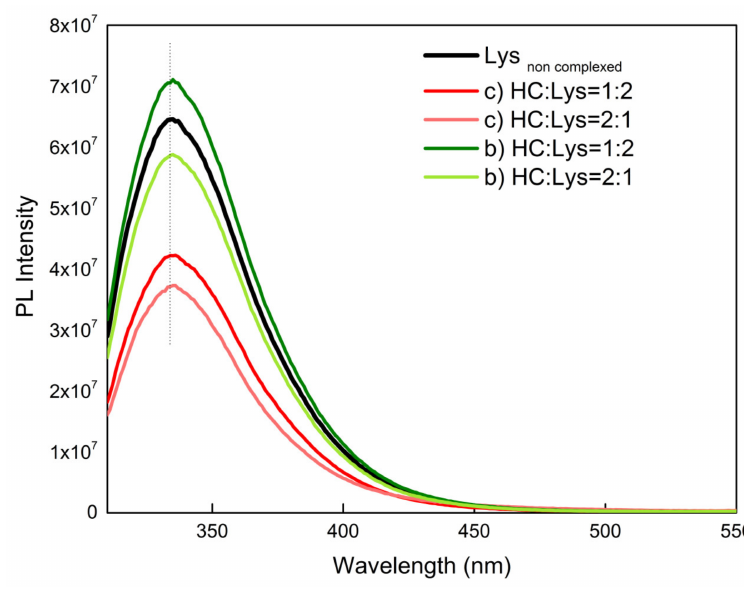
Figure 7. Fluorescence spectra of selected HC–Lys complexes.